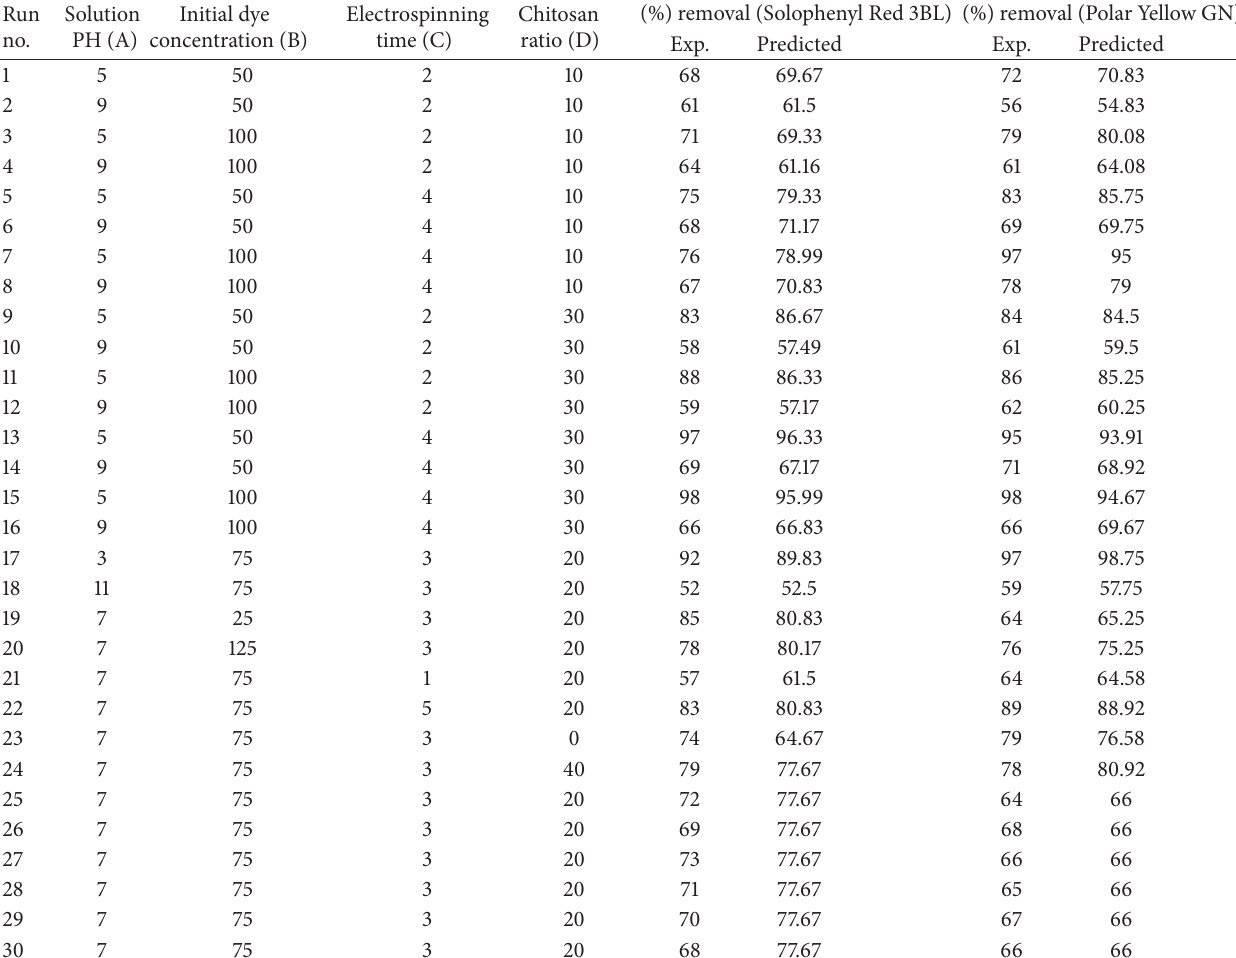
Table 3: Full factorial central composite design for removal of Solophenyl Red 3BL and Polar Yellow GN.